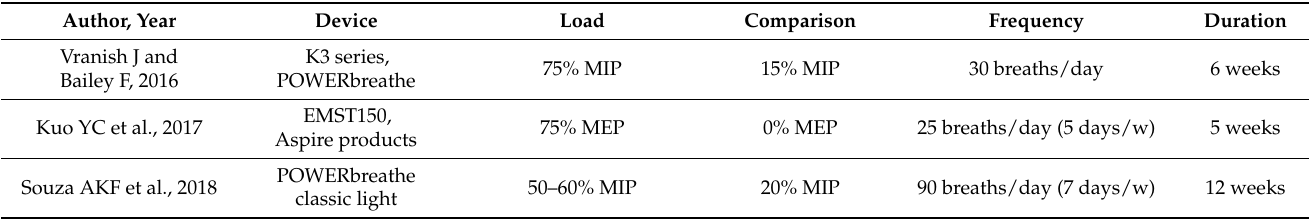
Table 2. Characteristics of respiratory muscle training